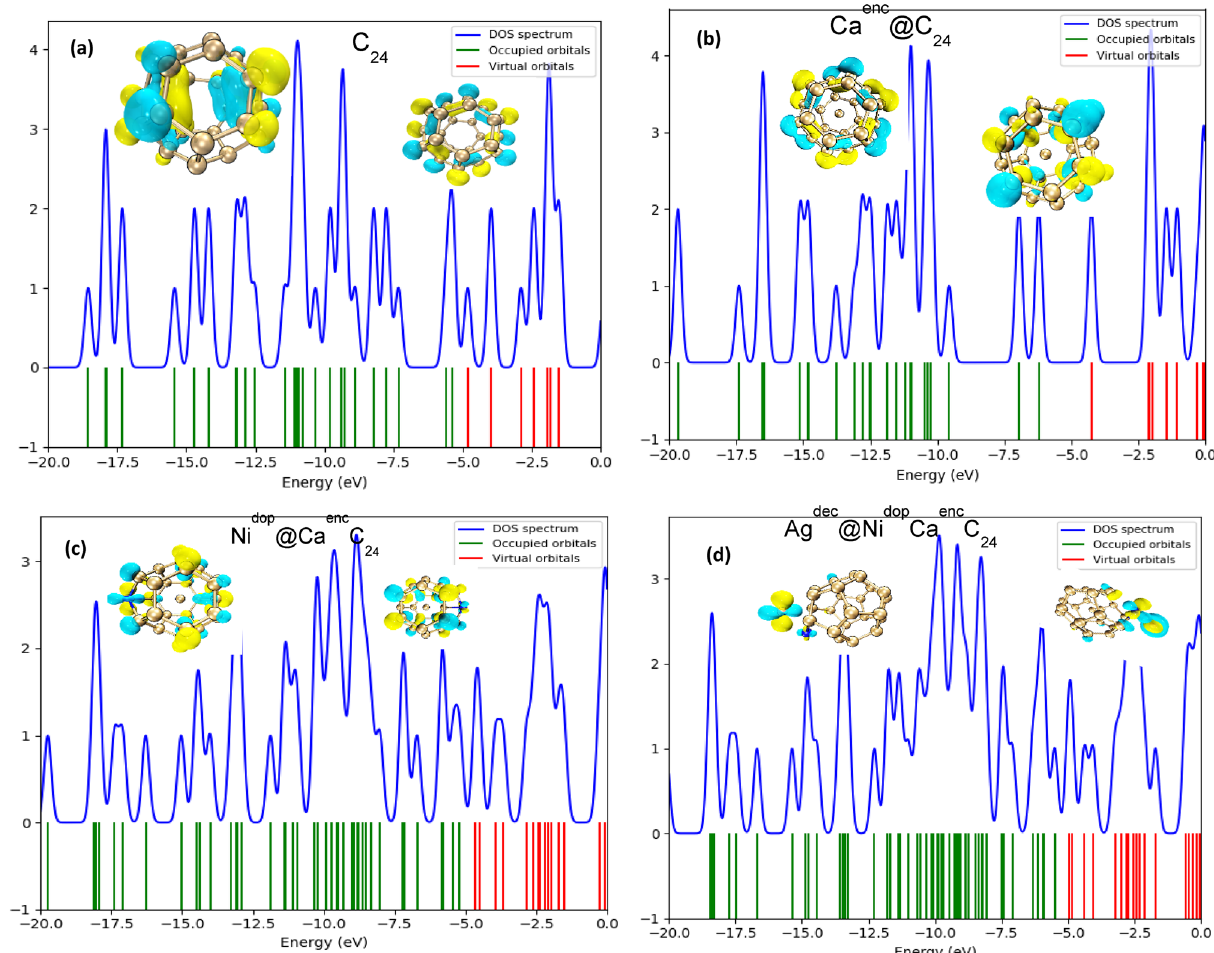
Figure 4. ( a–d ) HOMO and LUMO iso-surface distribution patterns and total density of state (TDOS) mapping of the studied bare systems (S 1 –S 4